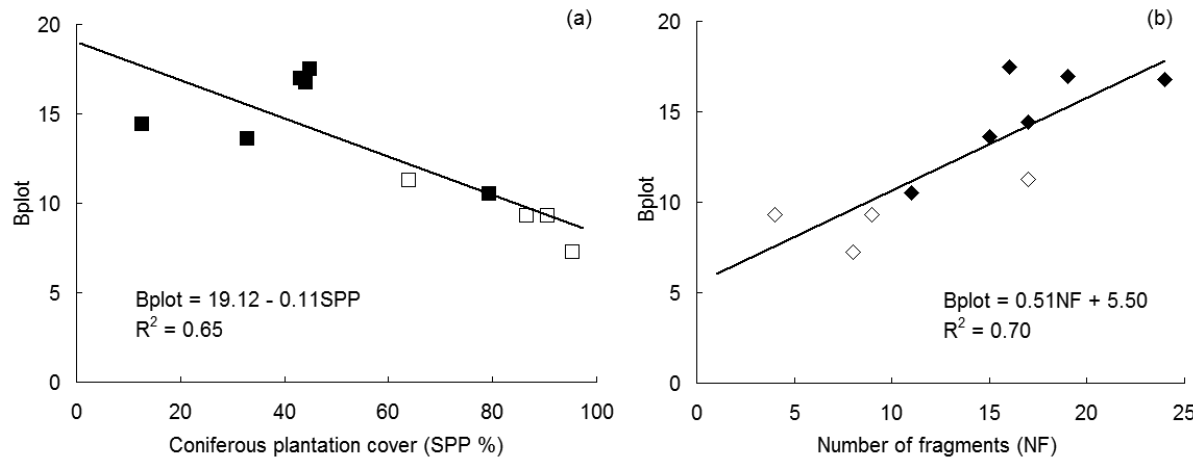
Figure 3. Linear regression analysis between mean biological value index attained per plot (Bplot) and (a) coniferous plantation cover (SPP%) or (b) number of fragments (NF, n). Open squares indicate absence and black ones presence of consolidated dwelling (more than 3 inhabited houses). Equations are